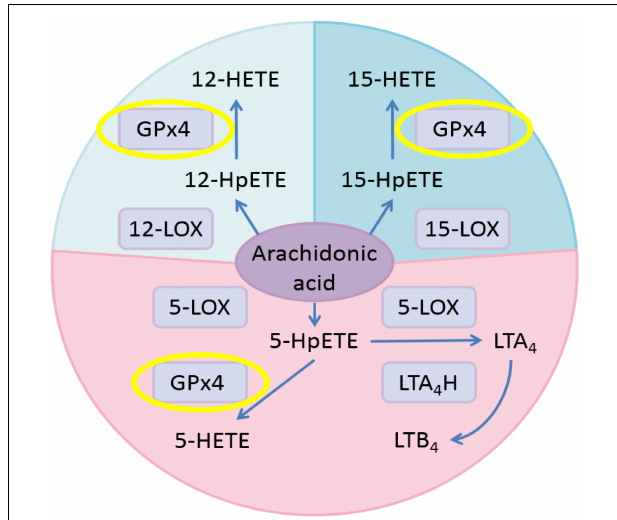
FIGURE 1 | Eicosanoid biosynthesis pathways related to GPX4 in the AA metabolic network. Pink, 5-LOX pathway; pale blue, 12-LOX pathway; blue, 15-LOX